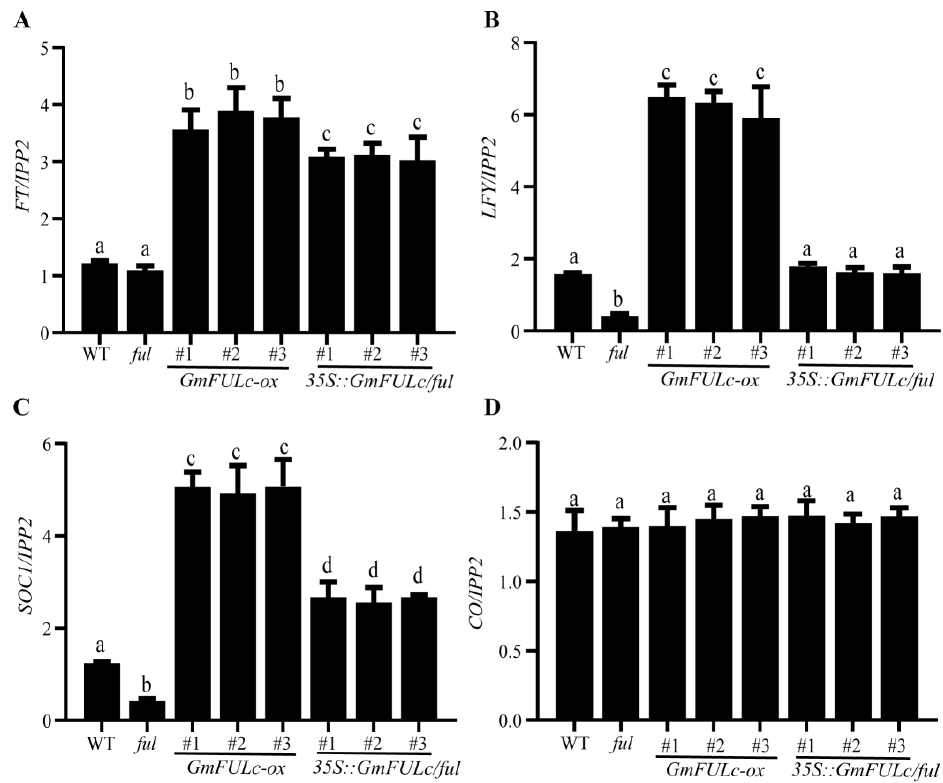
Figure 5. The transcriptional levels of FT , LFY, SOC1 and CO in GmFULc-ox , ful mutants,